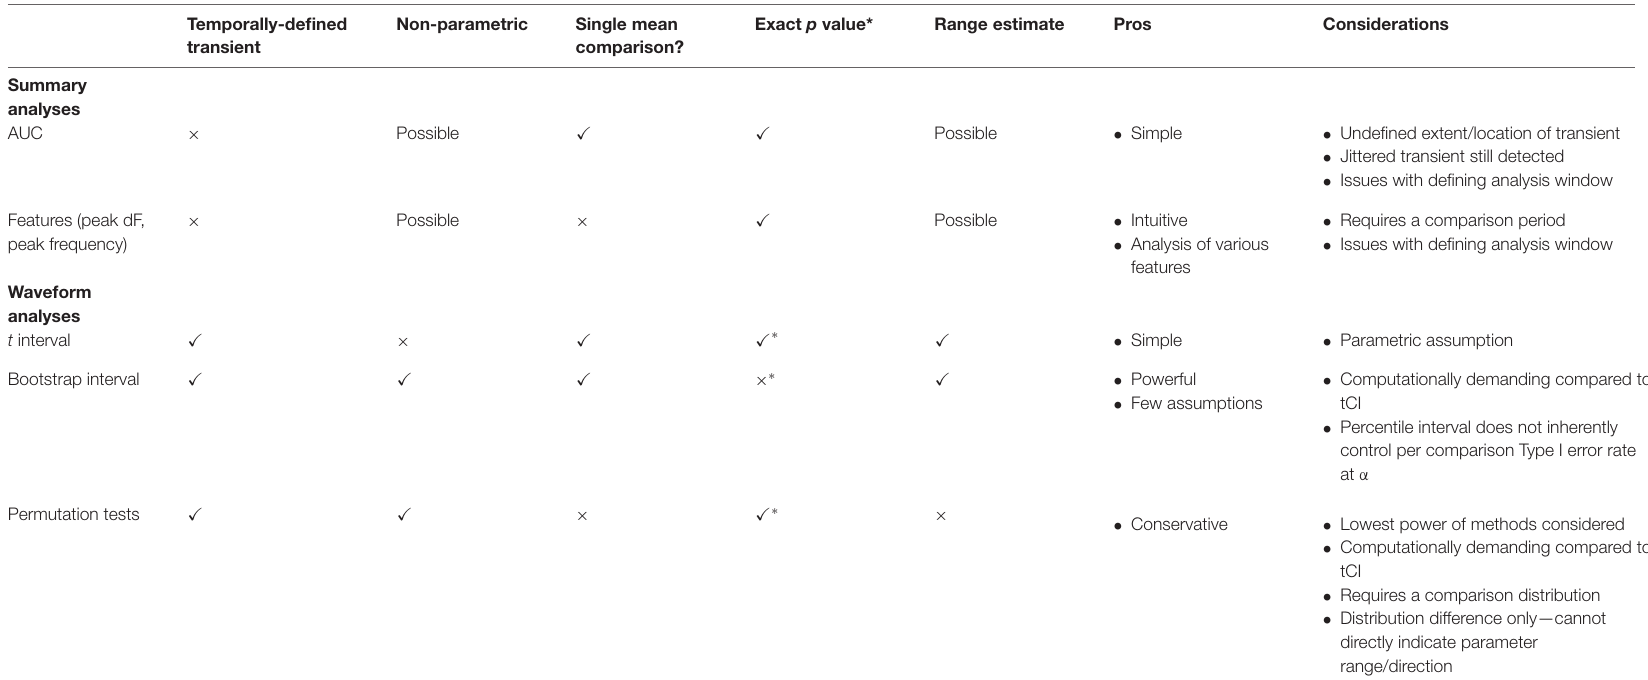
TABLE 1 | Overview of transient analysis